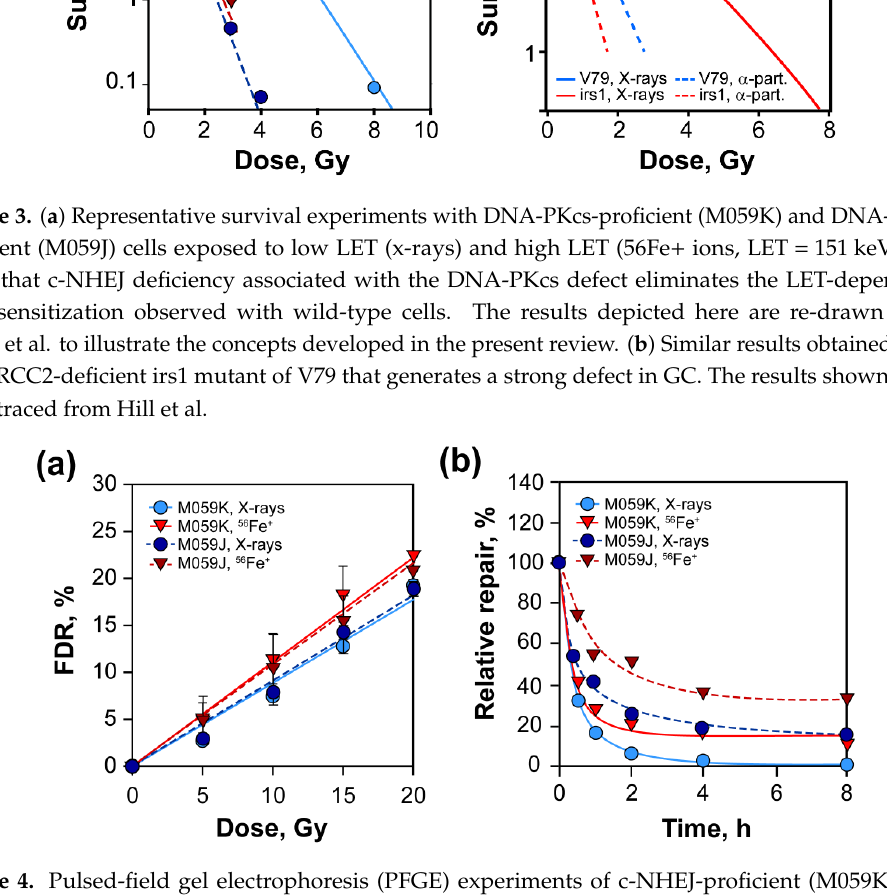
Figure 4. Pulsed-field gel electrophoresis (PFGE) experiments of c-NHEJ-proficient (M059K) and c-NHEJ-deficient (M059J) cells exposed to x-rays and 56Fe+ ions (LET 151 keV/µm). ( a ) Dose response curves of M059K and M059J cells exposed to low or high LET IR. Note that the induction of DSBs is